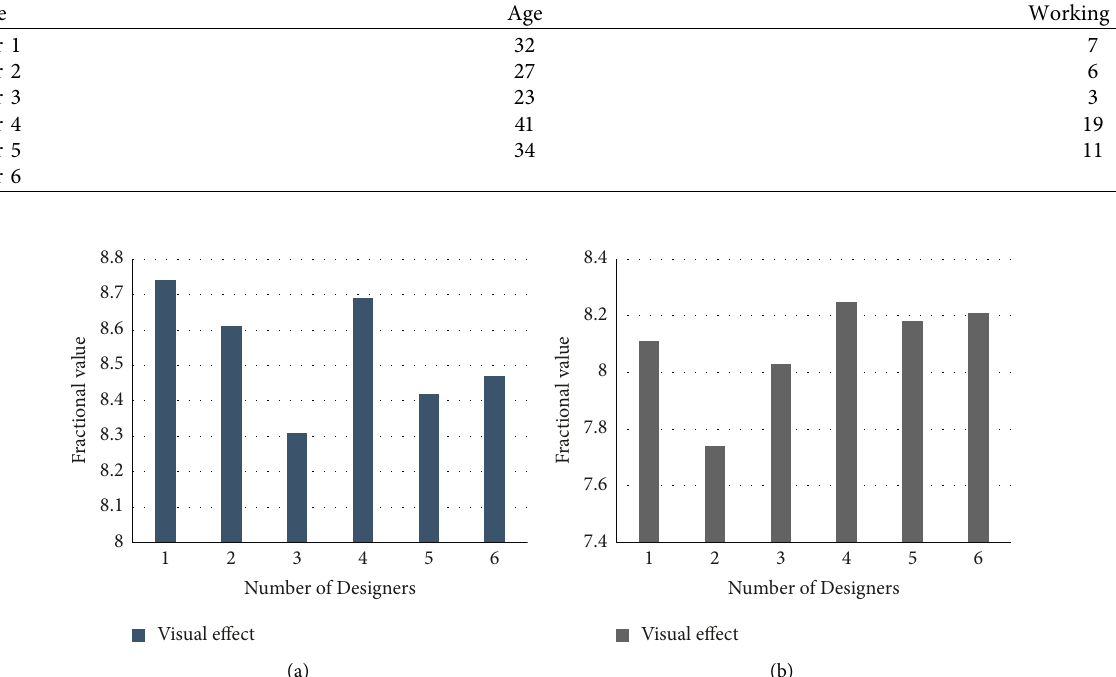
Figure 10: Visual effect test of pattern design. (a) The design score of the clothing pattern of the experimental group. (b) The clothing pattern design scores of the control